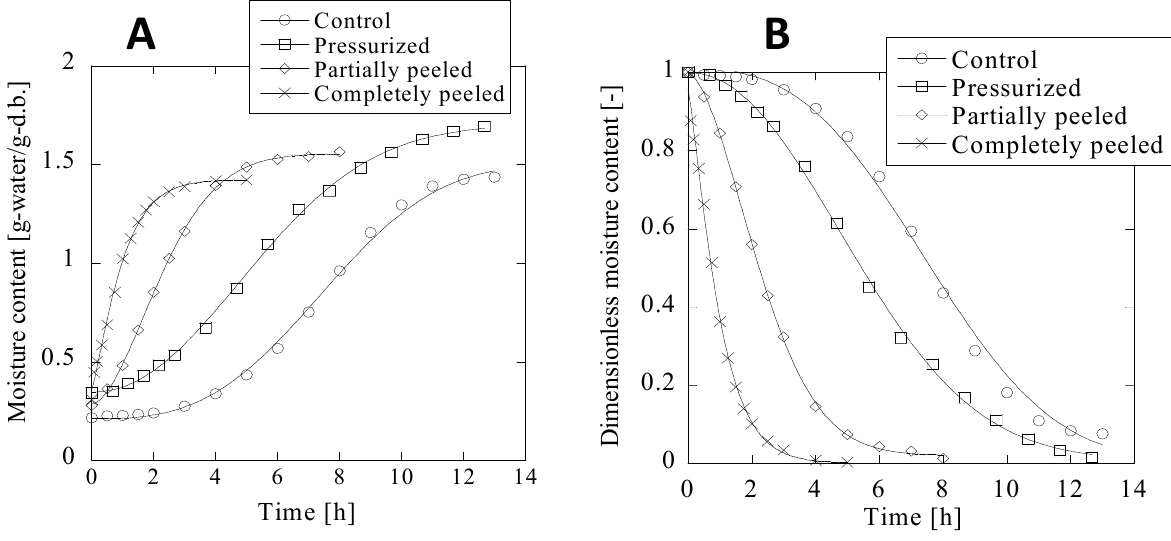
Figure 3. Changes in moisture content ( A ) and dimensionless moisture content ( B ) of adzuki beans, untreated control, HHP (200 MPs)-treated beans, partially peeled (30% peeled) beans, and completely peeled beans. Equations (4) and (5) were used to determine the moisture content and dimensionless moisture content,